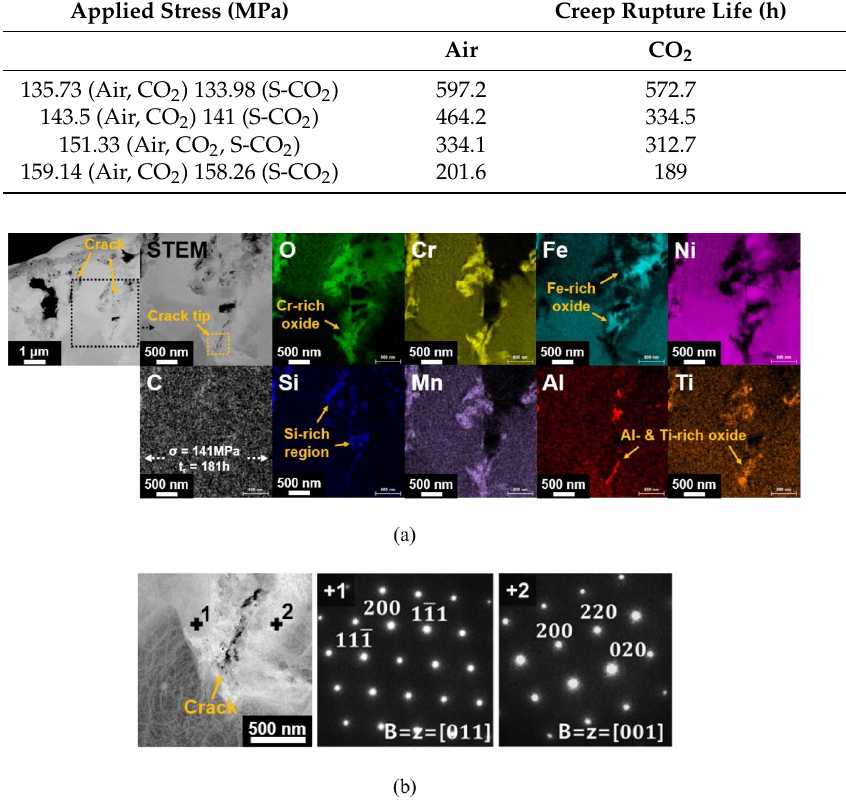
Figure 25. Results of TEM analyses of propagating crack region in S-CO 2 crept specimen about 5 mm away from the fracture region; ( a ) STEM micrograph and EDS mapping image; ( b ) enlarged micrograph of area indicated in ( a ) and SAD patterns of grains adjacent to crack [129]. Reproduced with permission from Elsevier.